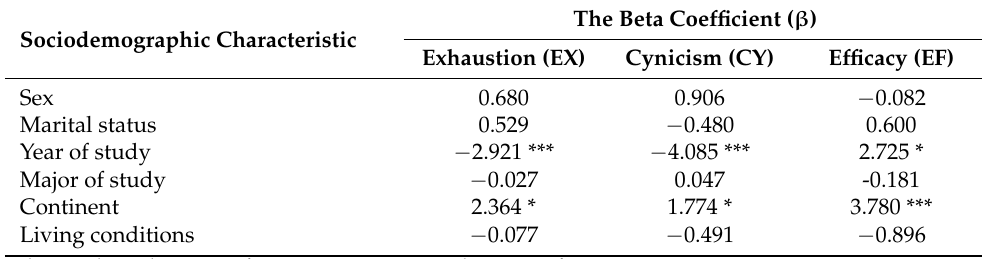
Table 4. Multivariate analyses on sociodemographic characteristics with academic burnout.